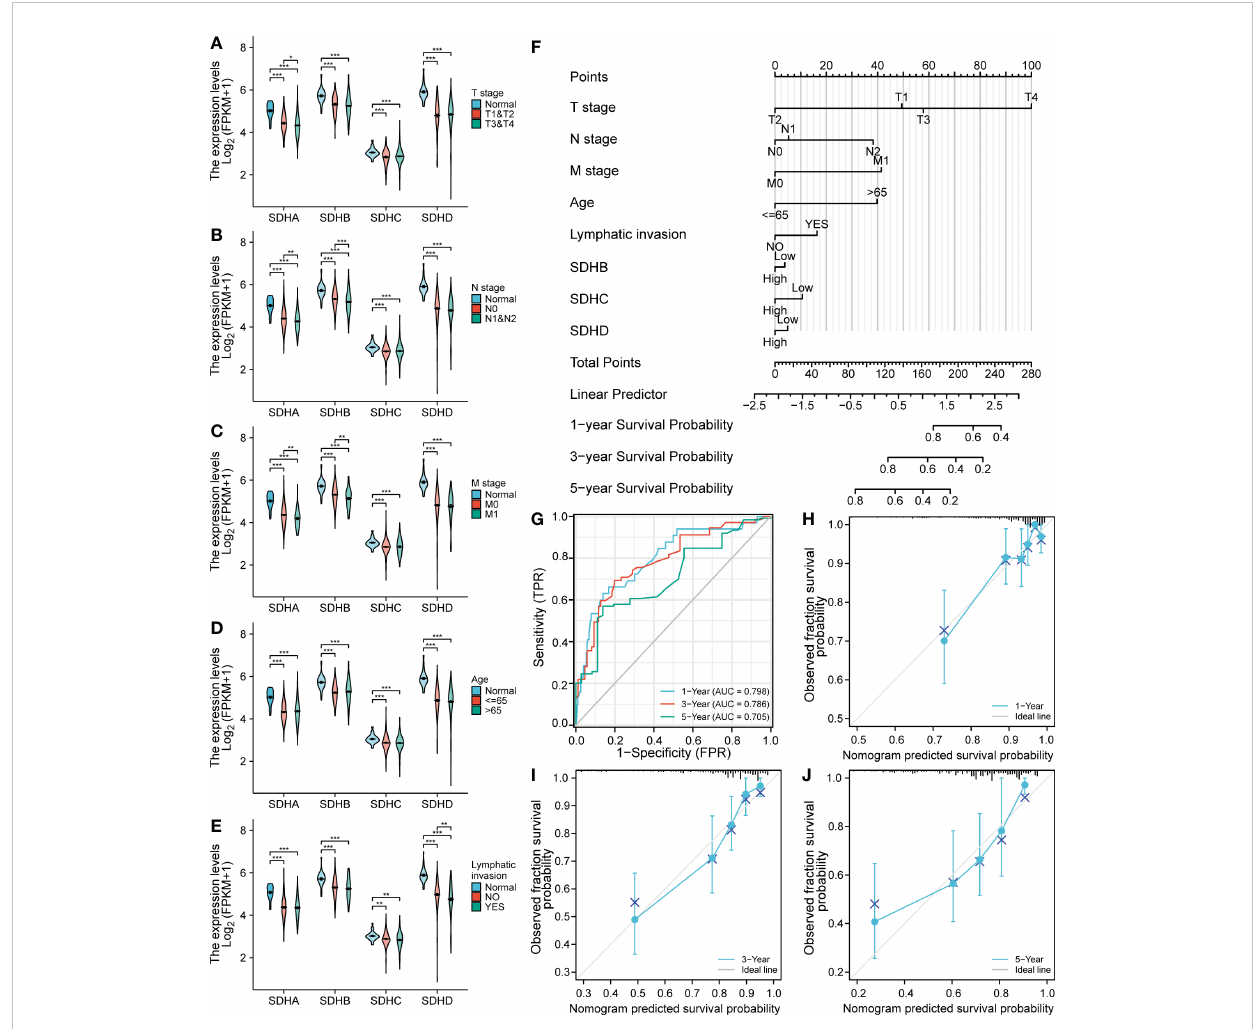
FIGURE 5 SDH factor expression and the clinical characteristics of patients with COAD. (A-E) SDHA, SDHB, SDHC, and SDHD are concerned with clinical characteristics involving T stage, N stage, M stage, age, and lymphatic invasion. (F) A nomogram to predict the overall survival rate of COAD patients. (G-J) Time-dependent ROC analysis and Calibration curve for the overall survival nomogram model in the discovery group. A dashed diagonal line represents the ideal nomogram. *p < 0.05; **p < 0.01 and ***p < 0.001; ns, not signi fi